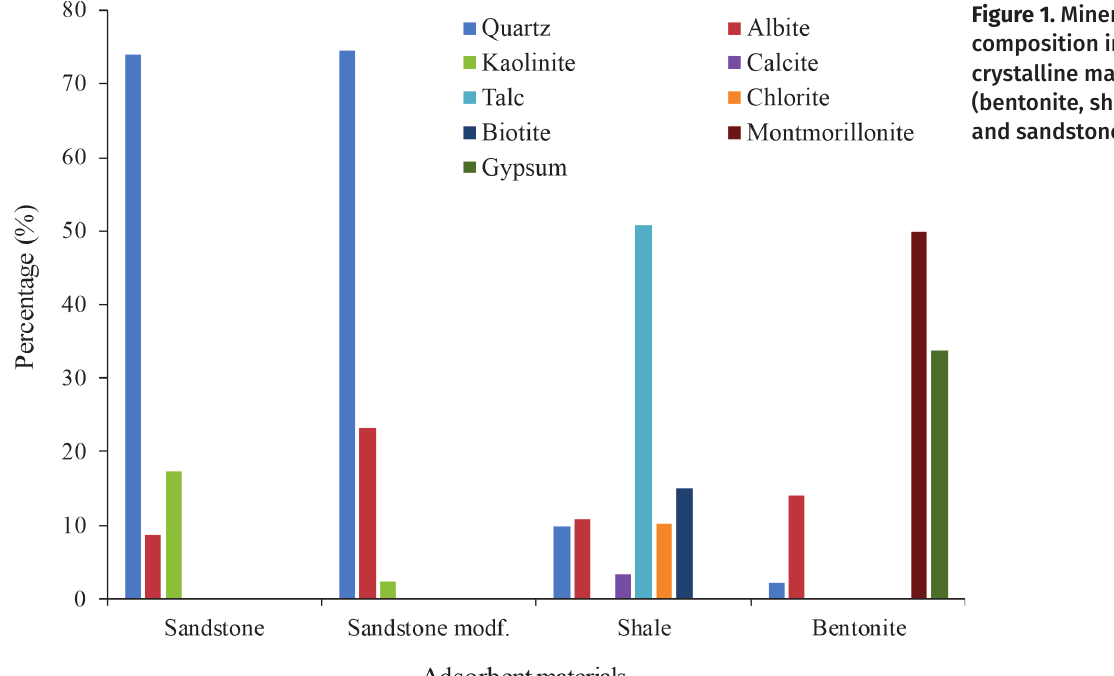
Figure 1. Mineral composition in crystalline